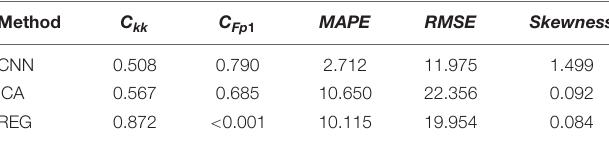
TABLE 5 | The averaged values of C kk , C Fp 1 , MAPE , RMSE, and Skewness for the F3 electrode.